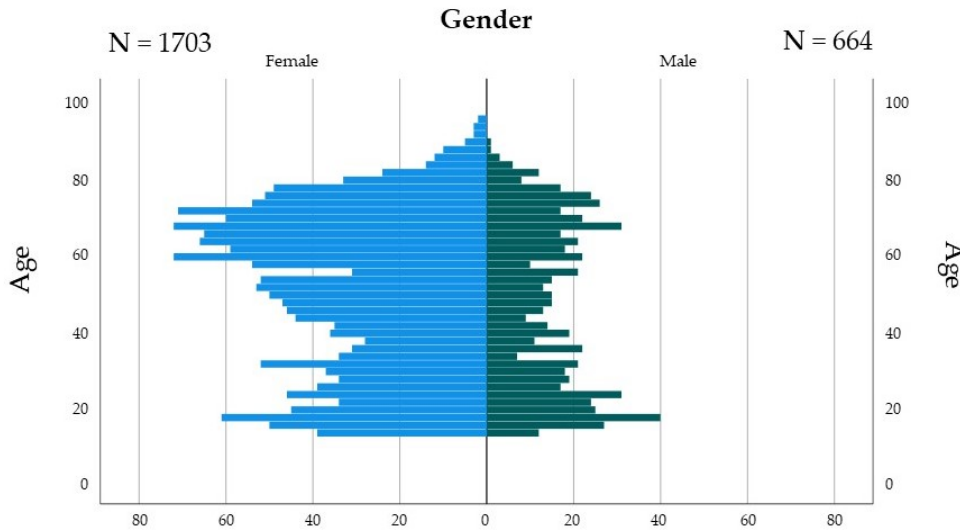
Figure 1. Demographic data of TMD patients for age.